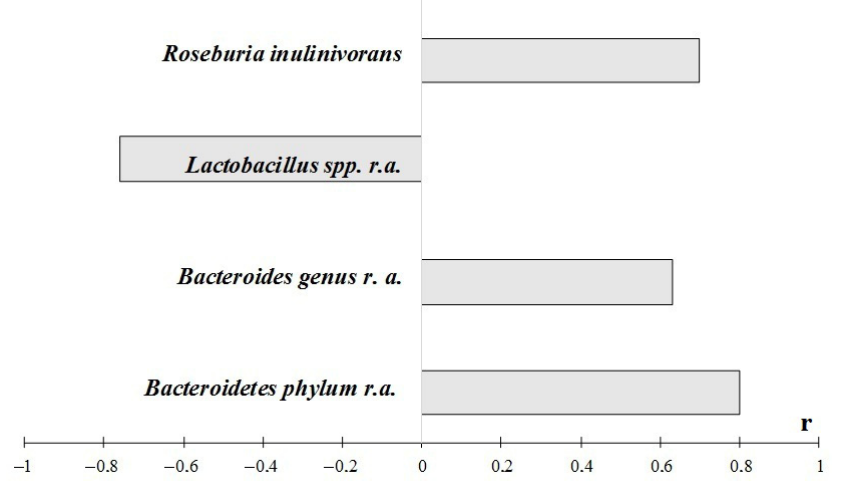
Figure 10. Coefficients of correlation between the quantity and relative abundance/quantitative content of bacterial taxa in intestinal microbiome and body weight at the end of the experiment. Notes: total data for all animals, the results of the study are presented using p < 0.05. A search for correlations between the studied parameters was performed using Spearman’s test. r.a.—relative abundance. The quantitative content of taxa was analyzed in other causes.